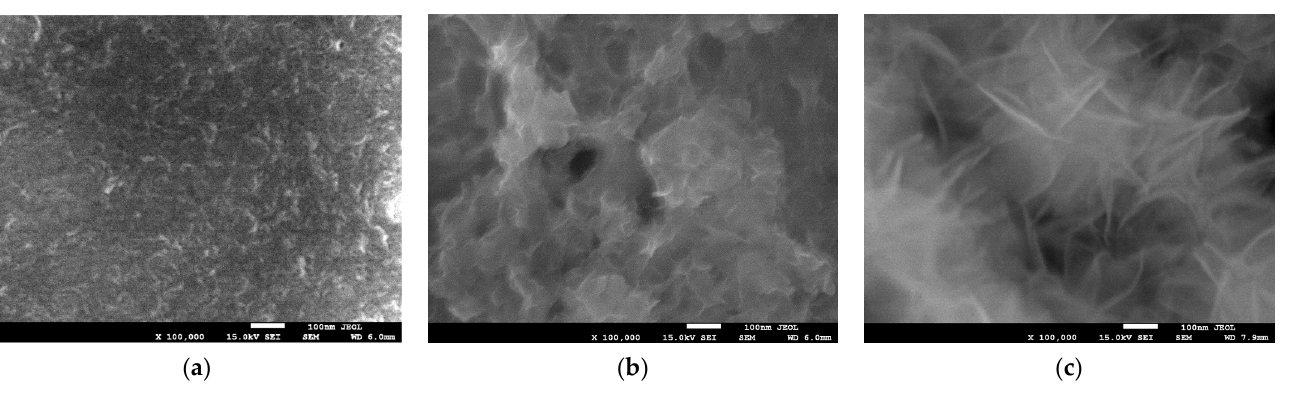
Figure 4. SEM micrographs of: ( a ) HT–Cl/im; ( b ) HT–Cl/s; ( c ) HT–Cl-ref.